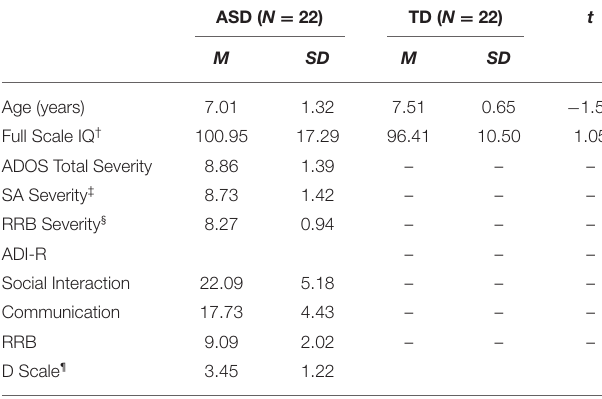
TABLE 1 | Characteristics of the